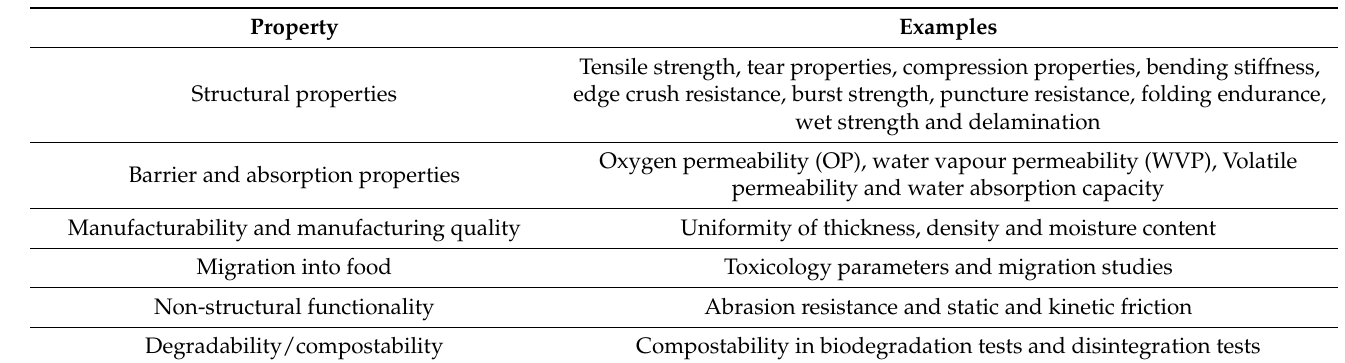
Table 2. Properties of packaging materials.Reprinted with permission from Ref. [81] Copyright 2008 Elsevier